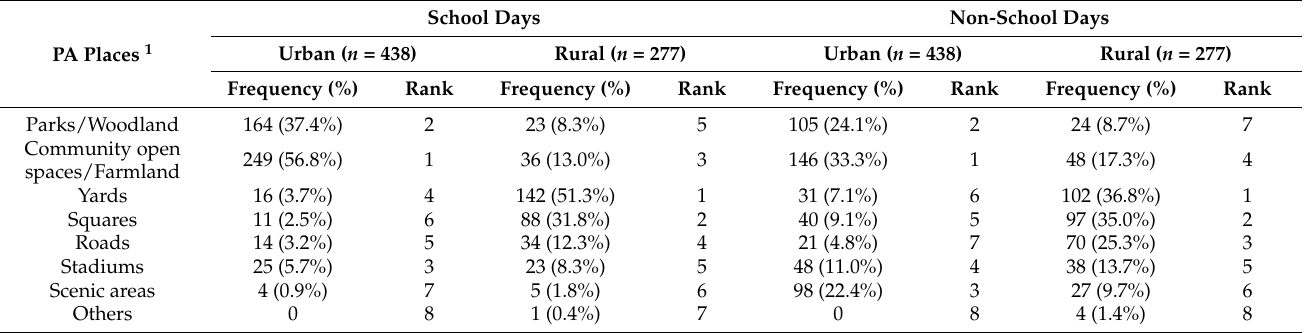
Table 4. PA Places Where Students Played on School Days and Non-school Days.